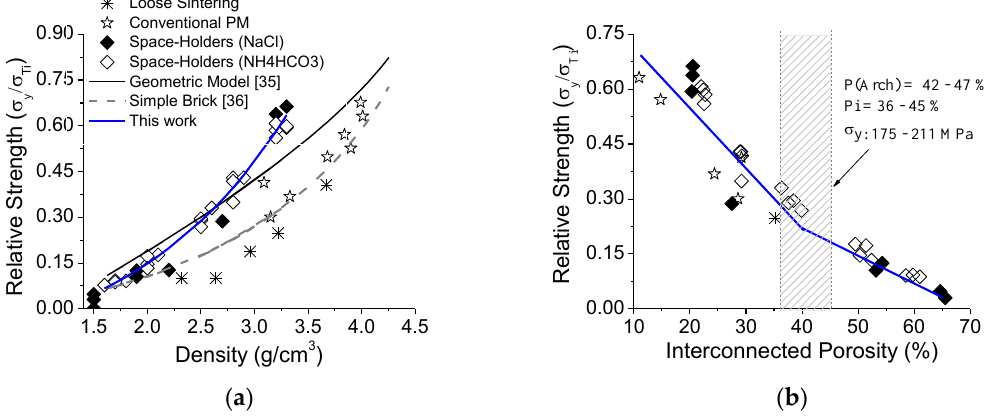
Figure 3. ( a ) Density vs. Relative Strength; ( b ) Interconnected Porosity and Relative Porosity vs. Relative Strength (porous material strength/full dense material strength).